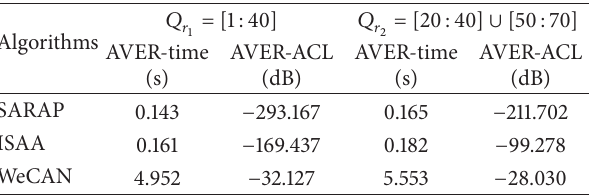
Table 2: Algorithms (initialized by random sequence) comparison for suppressing range sidelobes.